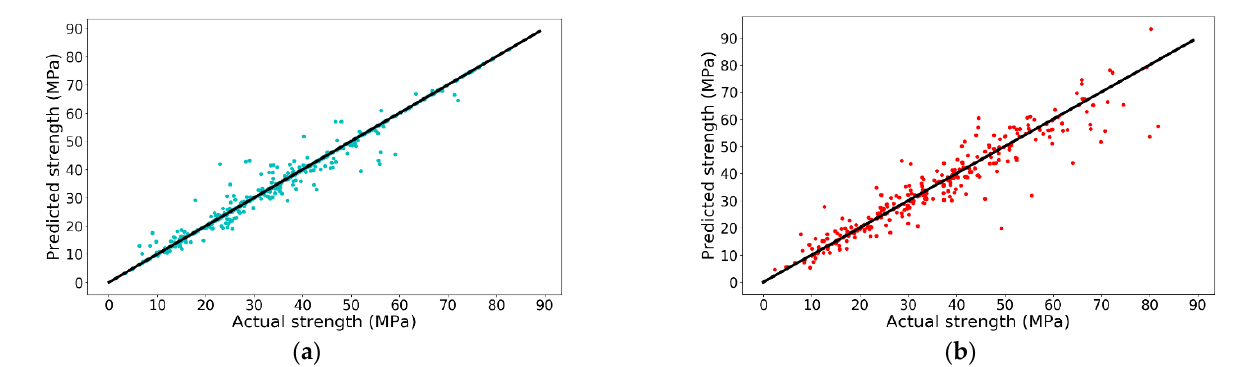
Figure 6. Prediction accuracy of SVR model on ( a ) training set and ( b ) test set.